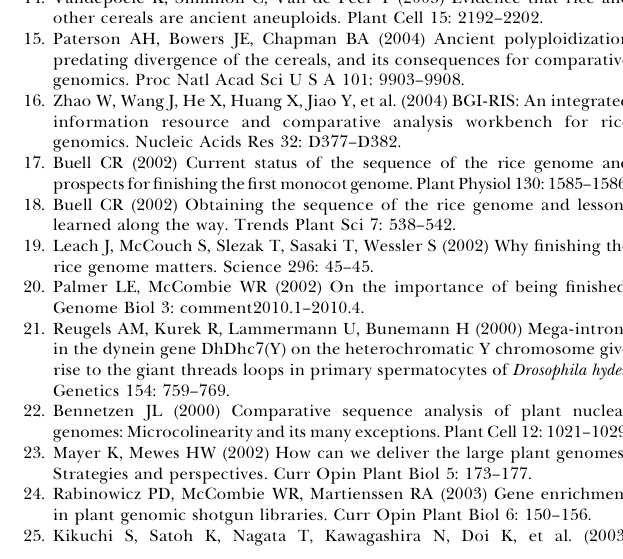
The DNA Data Bank of Japan/European Molecular Biology Labo- ratory/GenBank (BGI-RIS http://rise.genomics.org.cn [16])